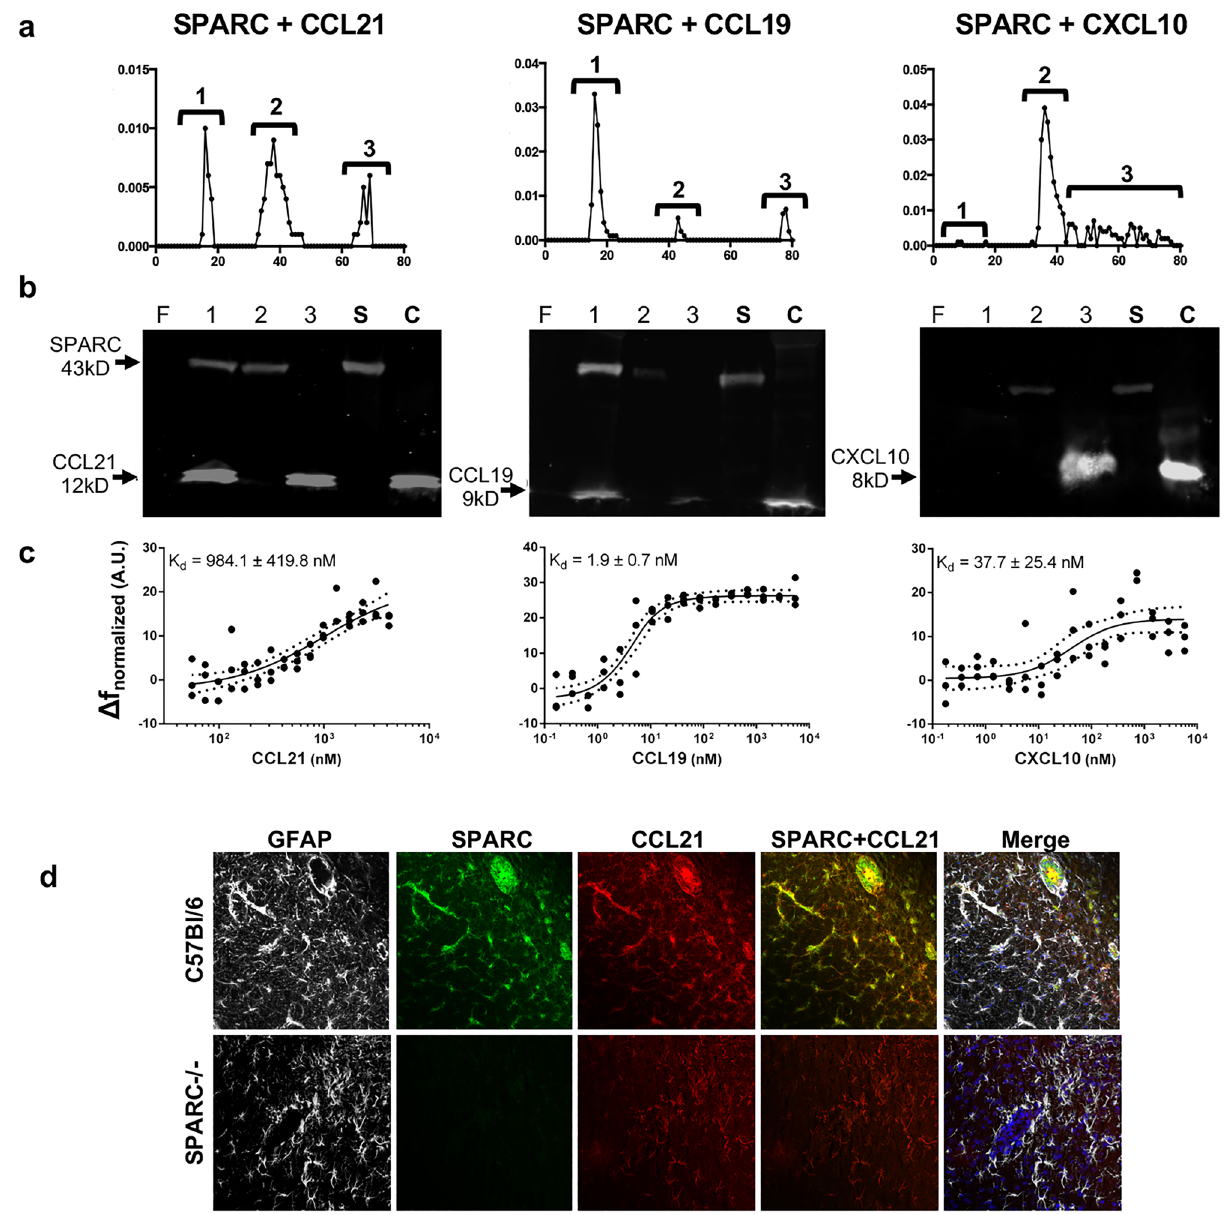
Figure 4. SPARC interacts directly with CCR7 ligands. Recombinant SPARC was incubated with CCL21, CCL19, CXCL10, or BSA (shown in Supplementary Fig. S2) and the mixture and applied to a Sephadex G-50 column. ( a ) The elution profiles (SPARC + CCL21; SPARC + CCL19; SPARC + CXCL10) are annotated to show which fractions were pooled and subjected to western blot. ( b ) Results from western Blots (SPARC + CCL21; SPARC + CCL19; SPARC + CXCL10) are shown under their respective elution profiles. ( c ) Thermophoretic plots (SPARC + CCL21; SPARC + CCL19; SPARC + CXCL10) are shown under their respective western blots. Values presented are the calculated dissociation constants ± SEM. The y-axis illustrates the thermophoretic response as observed by a change in normalized fluorescence in arbitrary units. Dotted lines illustrate the 95% confidence interval for the fit from non-linear regression. ( d ) Immunohistochemistry of chronically infected C56Bl/6 and SPARC−/− mice were incubated with antibodies to GFAP (white), SPARC (green), and CCL21 tive control to confirm that SPARC isn’t just sticky, SPARC was also run through the column in the presence of bovine serum albumin (BSA) (Supplementary Fig. 2). As expected, two distinct peaks eluted from the column in the fractions anticipated based on the molecular weight of each protein. To further confirm that proteins and protein complexes elute from the column as expected based on their molecular weights, individual proteins with distinct molecular weights were run through the column. BSA (66 kDa), Ovalbumin (45 kDa), Trypsin (23 kDa), and CCL19 (9 kDa) all eluted from the column in the fractions expected due to their size (Fig. S2). These data indicate that SPARC binds CCR7 ligands, however it is unlikely to bind CXCL10. To determine if